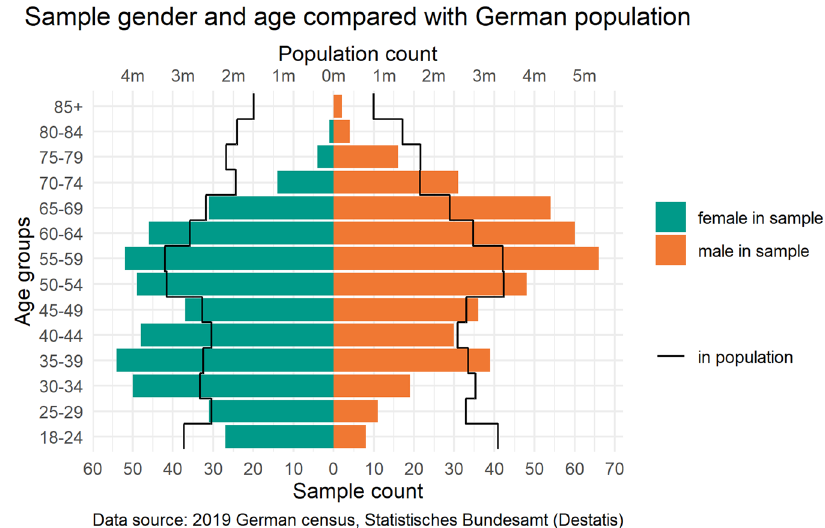
Fig. 3 Age and gender of the survey sample compared with the German population (Statistisches Bundesamt (Destatis), 2020). Men under 35 and women over 70 are underrepresented.